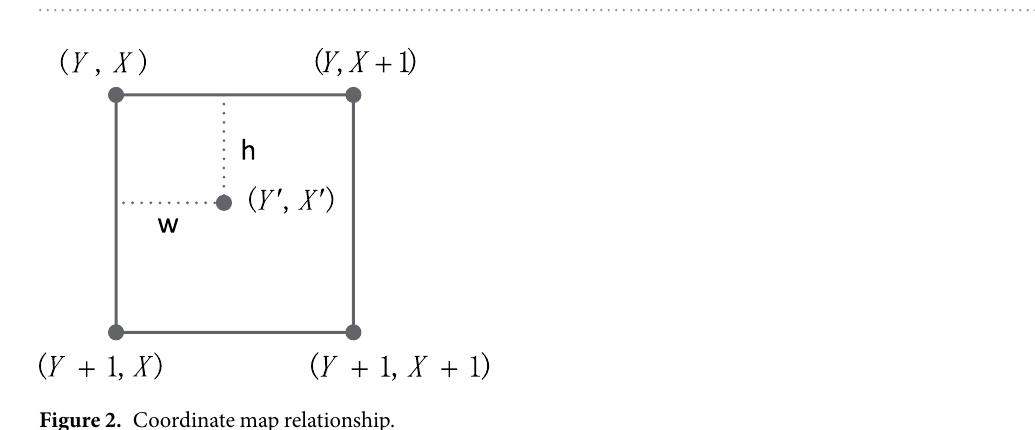
Figure 1. An example of 2 × 2 image and its NEQR.